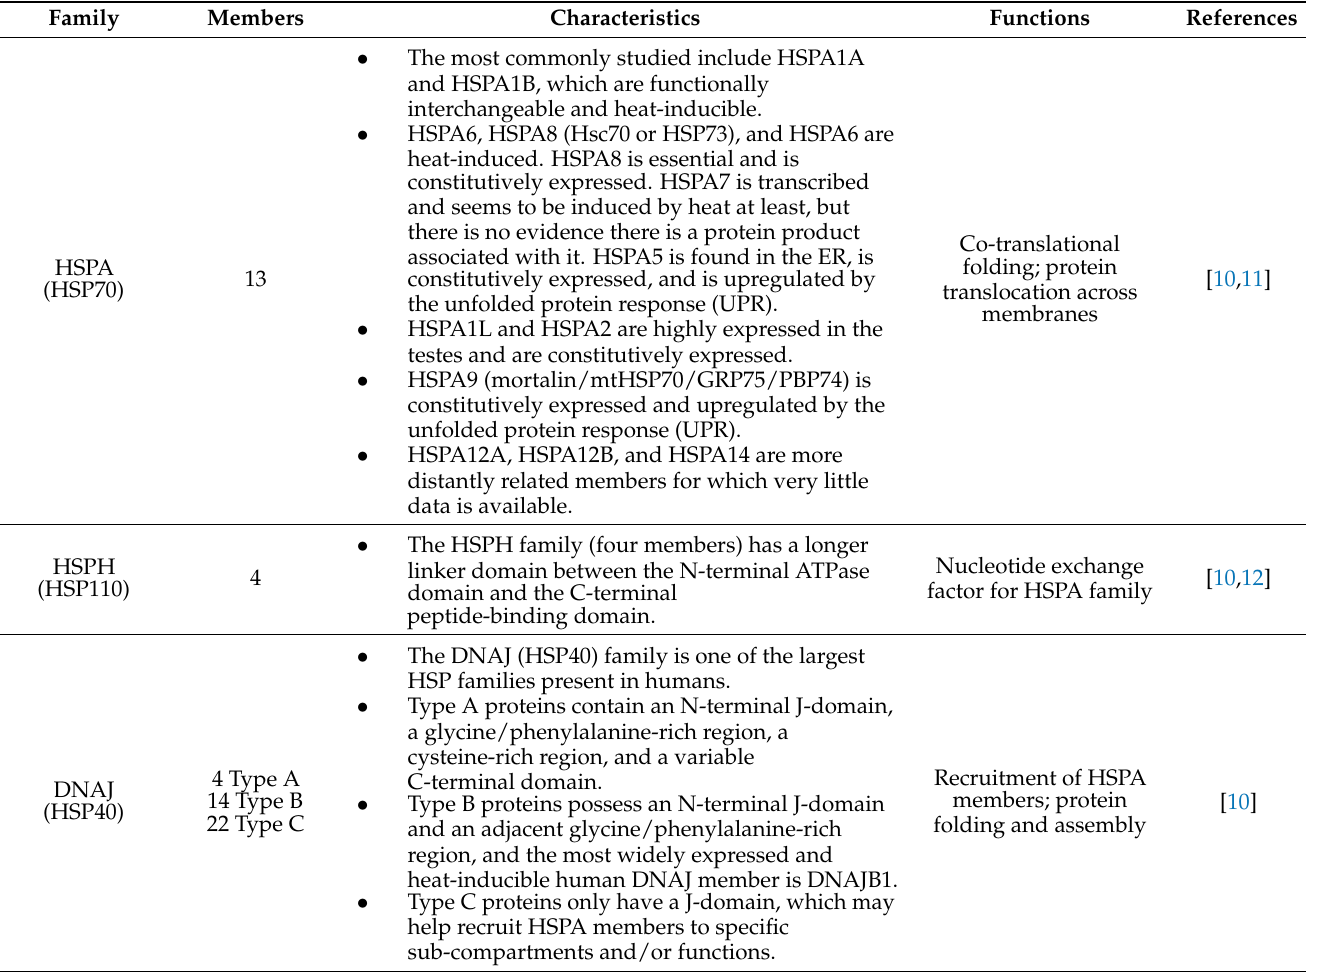
Table 1. Classification of heat-shock proteins